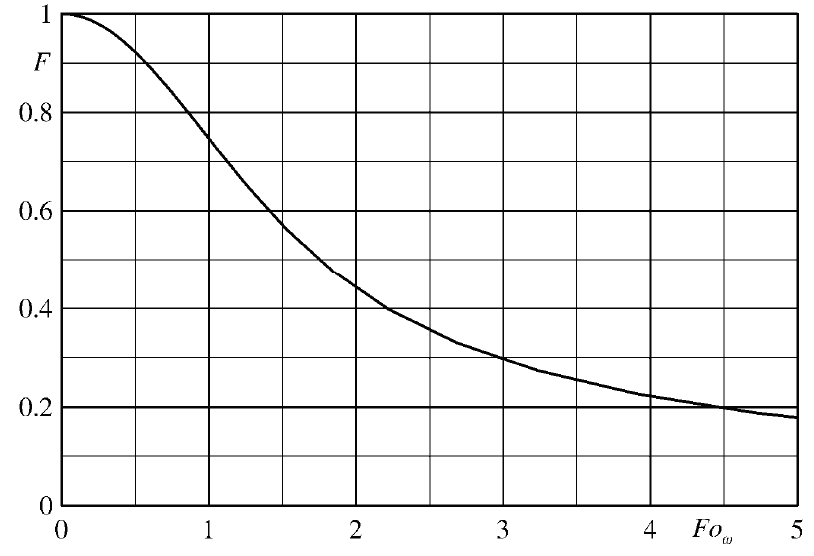
Figure 8. Temperature modulation transfer function F for the thin film sensor. Adapted from